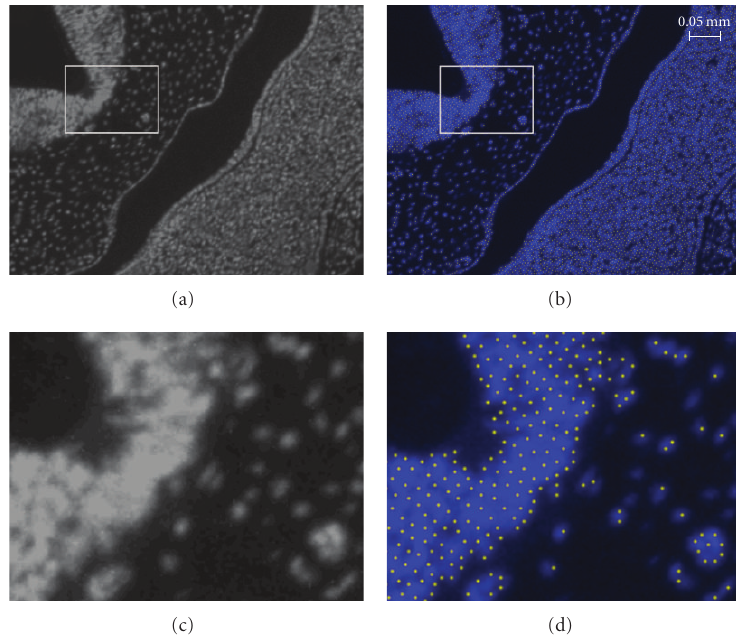
Figure 6: Details of ICS results. (a) Detail view of a DAPI-stained sample obtained through brightfield microscopy. The image has been converted to grayscale and contrast enhanced for viewing clarity. The blue regions in (b) show the color of the original image and correspond to the white regions in (a). Figures (c) and (d) are zoomed windows (4x magnification) of (a) and (b), respectively. The yellow dots in (d) show the cell location markers placed by ICS in